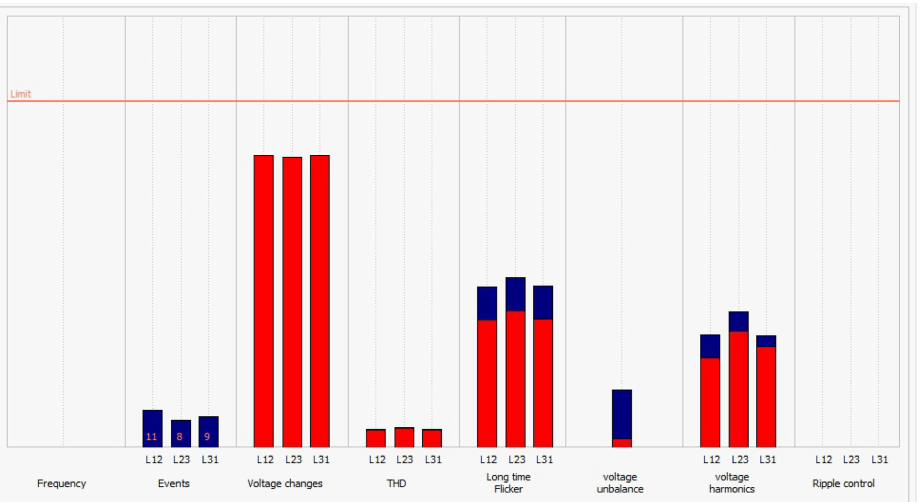
Figure 26. Final report on the assessment of voltage quality in PCC in accordance with PN-EN